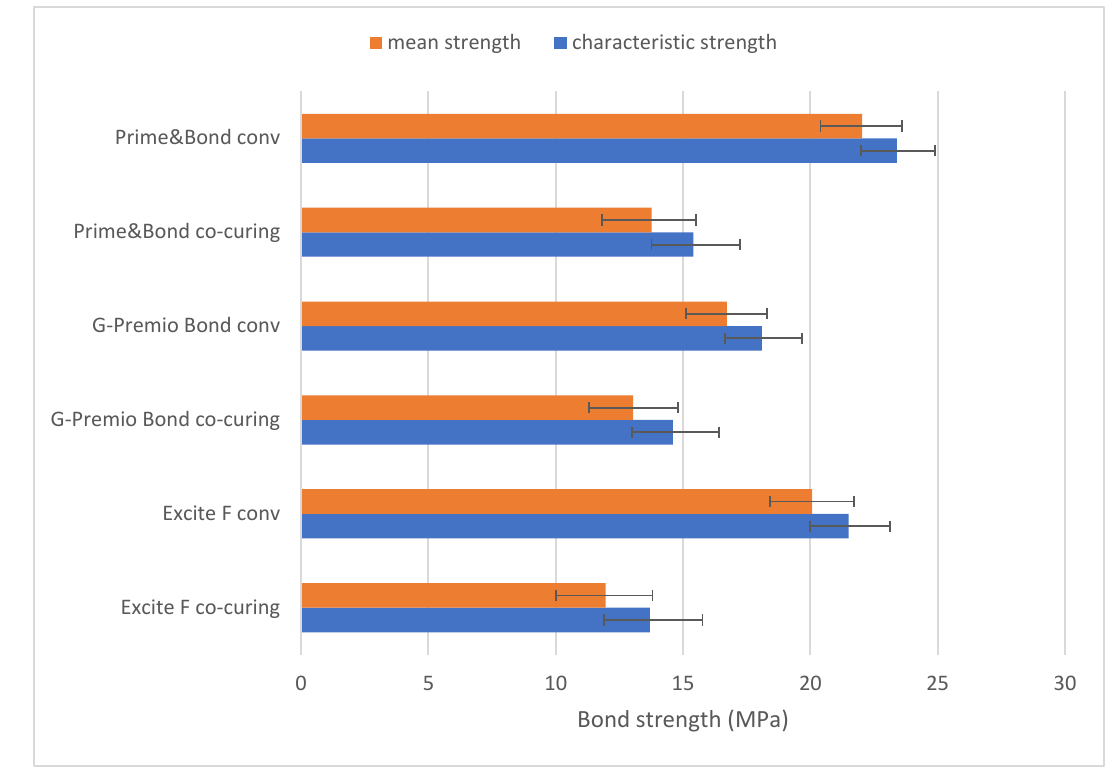
Figure 5. Comparison of characteristic strength ( Pf ≈ 63.2%) and mean strength ( Pf = 50%) across experimental groups. Note: Error bars represent 95% confidence intervals.